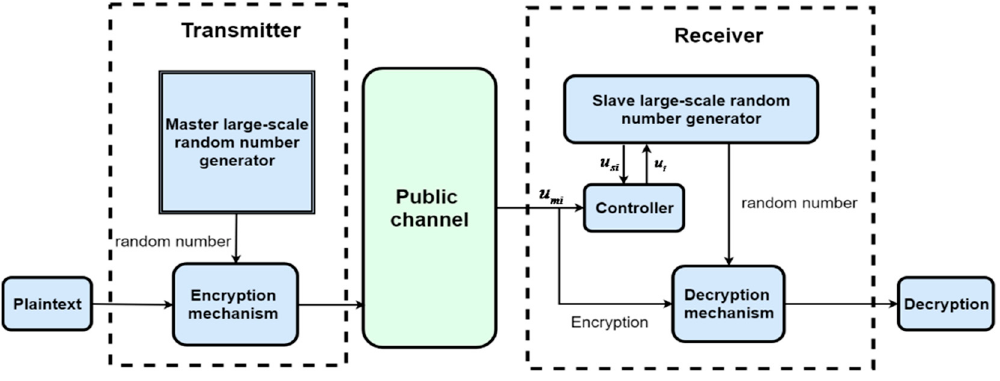
Figure 13. Communication system design.